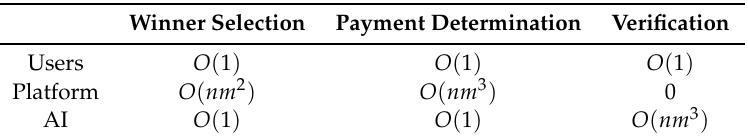
Table 5. Computation overhead of PVI-S.